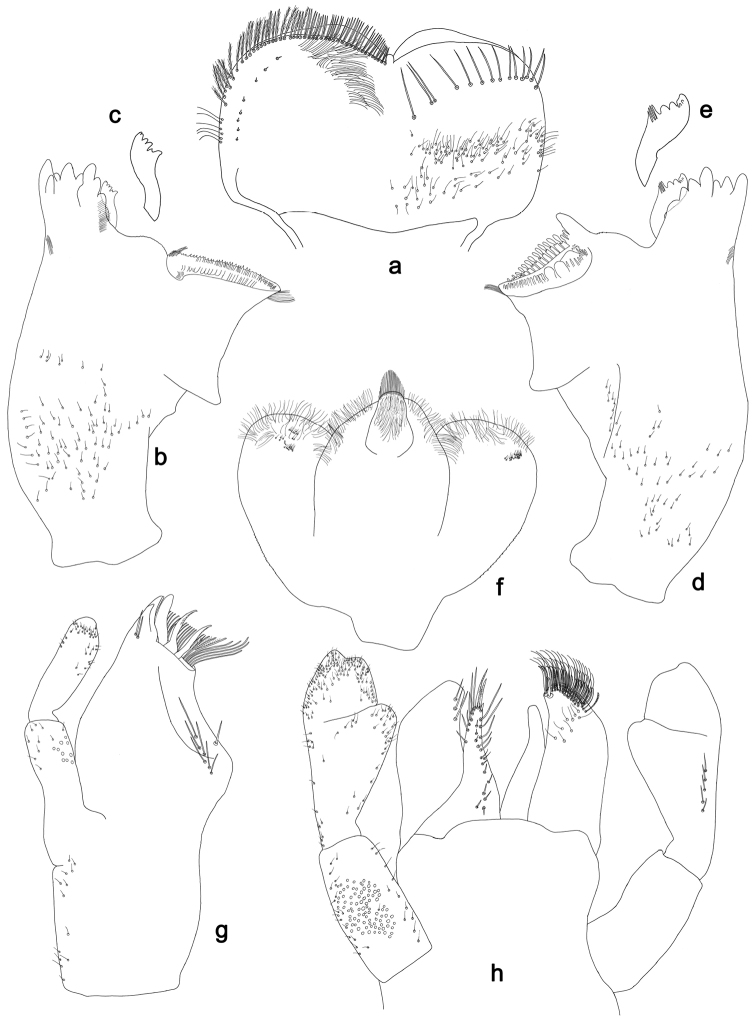
Labiobaetiselisae sp. n., larva morphology: a Labrum b Right mandible c Right prostheca d Left mandible e Left prostheca fHypopharynxg Maxilla h Labium.